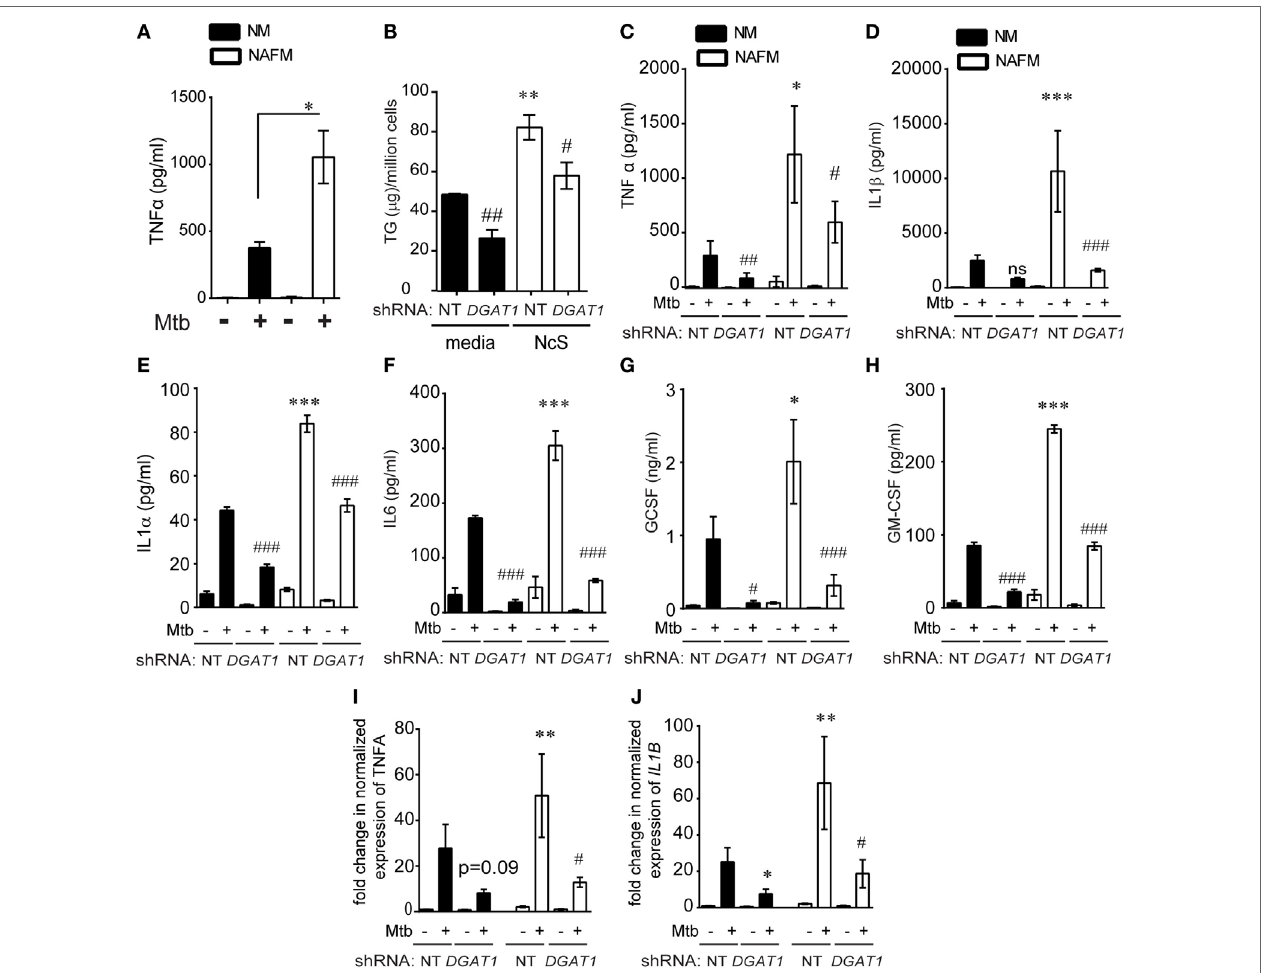
FigUre 6 | DGAT1-mediated TG synthesis is responsible for the heightened inflammatory response to Mycobacterium tuberculosis (Mtb) infection in foamy macrophages. (a) TNF α release measured by ELISA in supernatants from THP1 cells that were normal media treated (termed as normal macrophages or NM) or treated with necrotic cell supplement (NcS) for 8 days [termed as necrosis-associated foamy macrophages (NAFMs)] at 24 h after infection with Mtb at multiplicity of infection (MOI) 50 for 3 h. Data are mean ± SEM from three independent experiments (* p < 0.05). (B) TG estimation from NT and DGAT1 knockdown THP1 macrophages at 8 days post differentiation with media or NcS. Data are mean ± SEM from triplicate experiments. (c) TNF α release measured by ELISA in supernatants from NM and NAFM of NT and DGAT1 knockdown THP1 macrophages at 24 h post infection with Mtb at MOI 50 for 3 h. Data are mean ± SEM from three independent experiments. (D–h) Luminex-based detection of indicated cytokines in supernatants from Mtb-infected NM and NAFM of DGAT1 and non- targeting shRNA expressing macrophages. Data are mean ± SEM from five to six wells from two independent experiments. Transcript abundance of TNF α (i) and IL1B (J) normalized to that of PPIA in NMs and NAFMs of NT and DGAT1 shRNA expressing THP1 macrophages. Data are mean ± SEM from three experiments (*** or ### p ≤ 0.01, ** or ## p ≤ 0.01, * or # p ≤ 0.05, ns, not significant). * represents comparison between NAFM and NM and # represents comparison between DGAT1 knockdown and non-targeting control (NT) expressing macrophages for each group. See also Figure S5 in Supplementary